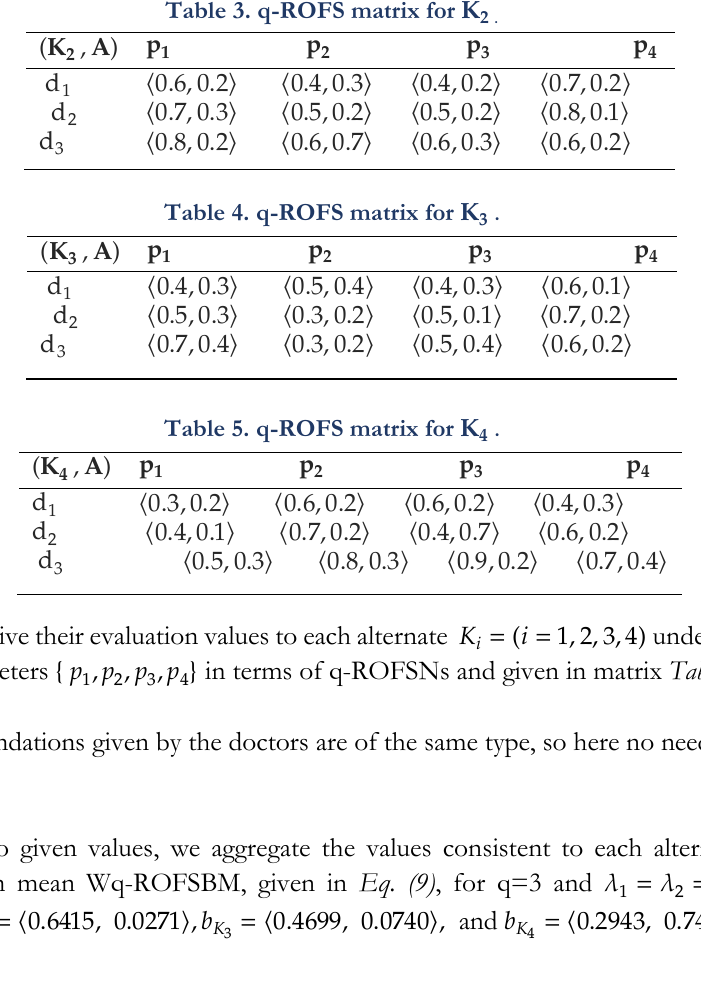
Table 3. q-ROFS matrix for 𝐊